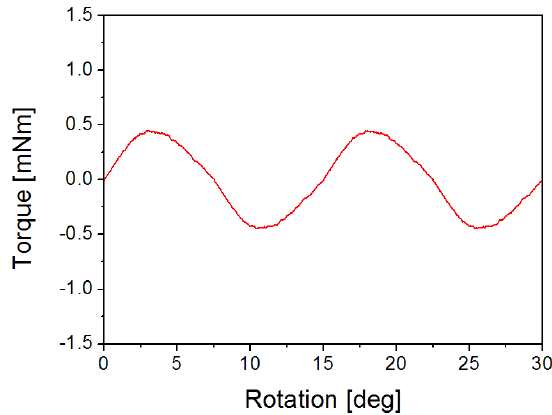
Figure 11. Experimental results of the cogging-torque measurement.